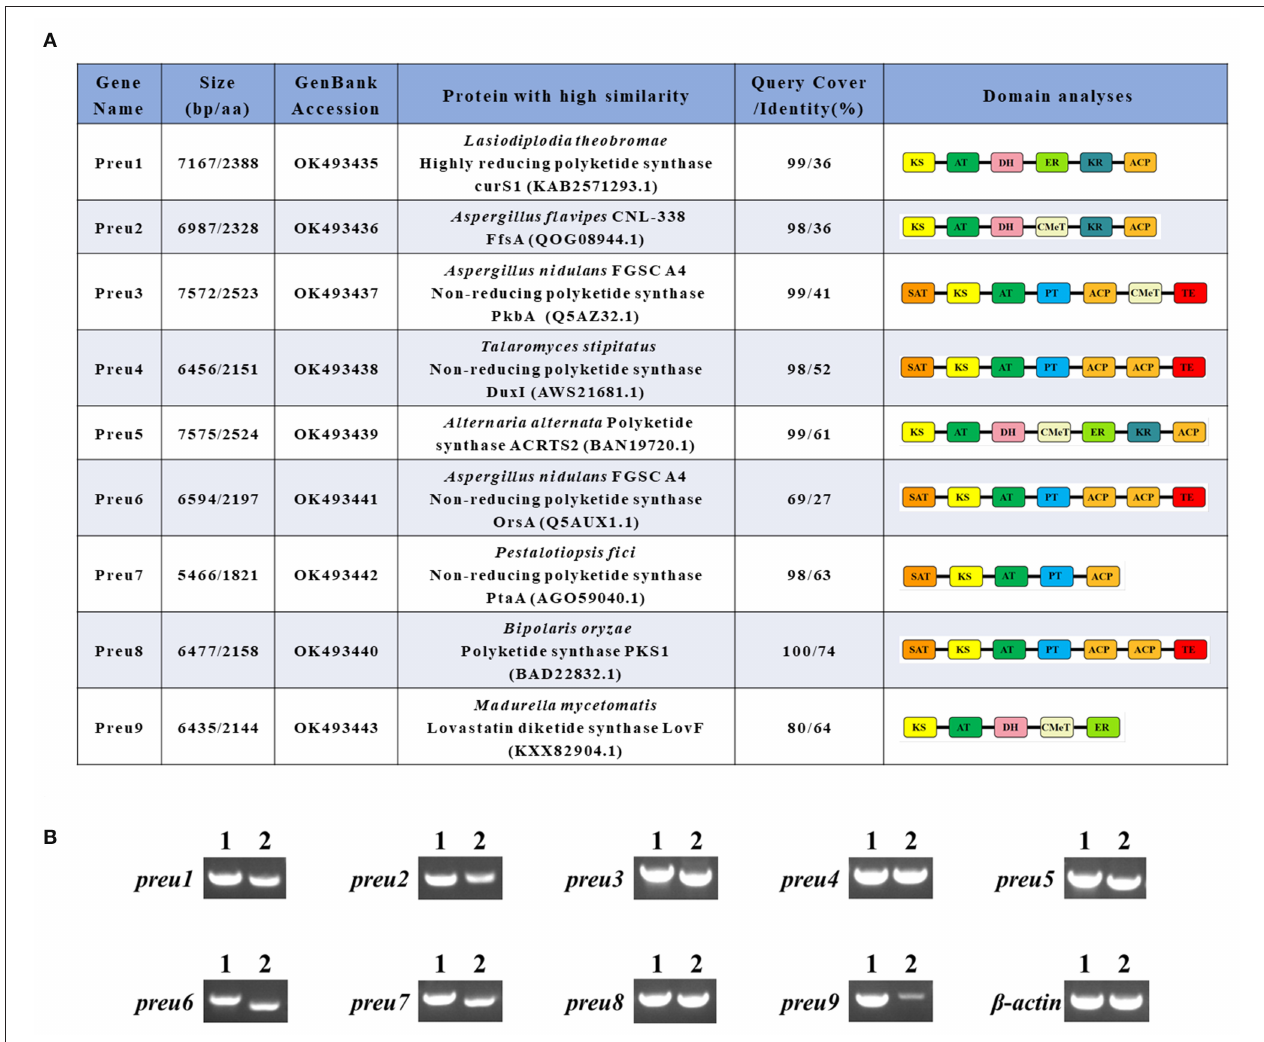
FIGURE 2 | Bioinformatic and transcriptomic analysis of PKSs Preu1–Preu9 from P. isomera XL-1326. (A) Annotation of Preu1–Preu9 and their percent identities with other characterized PKSs in the specific biosynthetic gene clusters. (B) RT-PCR analysis (2) of the genes preu1 – preu9 in the P. isomera XL-1326 strain cultivated on PDA plates for 5 days at 28 ◦ C. PCR products from genomic DNA (1) are shown for comparison. Three biological replicates were analyzed, and for each targeted gene, three technical replicates were performed. β -actin was used as the reference gene. The sizes of the corresponding PCR products are listed in Supplementary Table S1